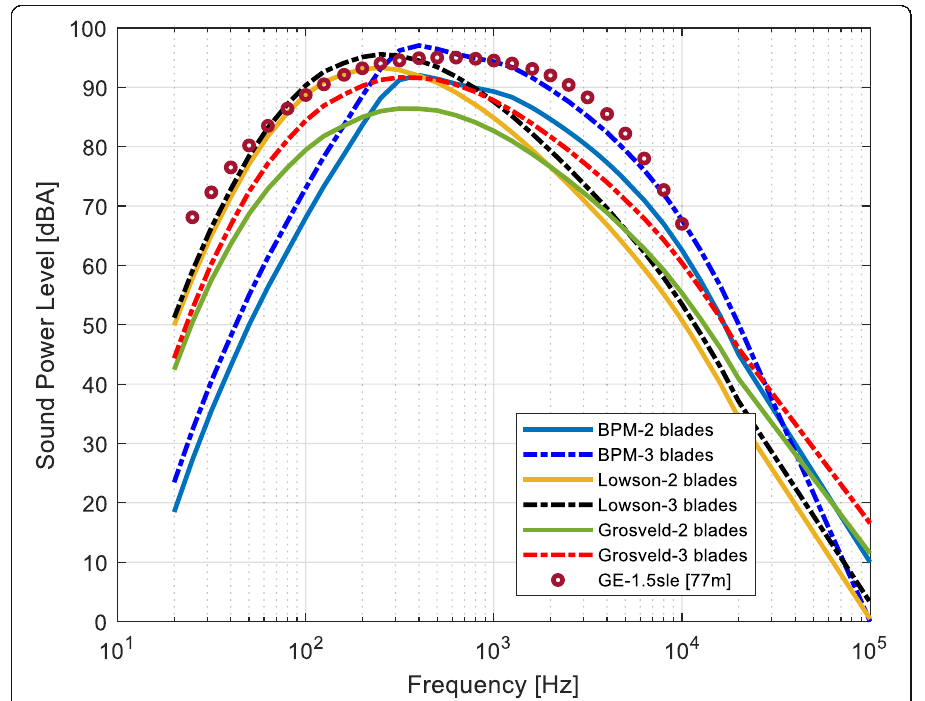
Fig. 9 Validation of computed sound power level from BPM, Grosveld and Lowson methods for 2 MW wind turbine with a rotor diameter of 76 m and three blades, with measured data of GE-1.5sle wind turbine with three blades and a rotor diameter of 77 m at wind speed, U 10 = 10